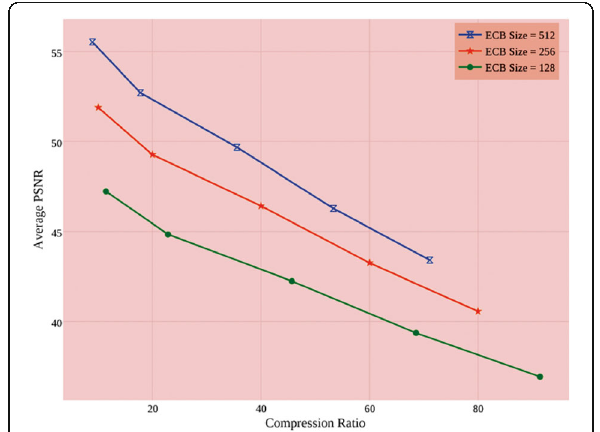
Fig. 15 Average CR Vs average PSNR graph for ECB size = 512, 256, and 128 for DB3 using PE-VQ method